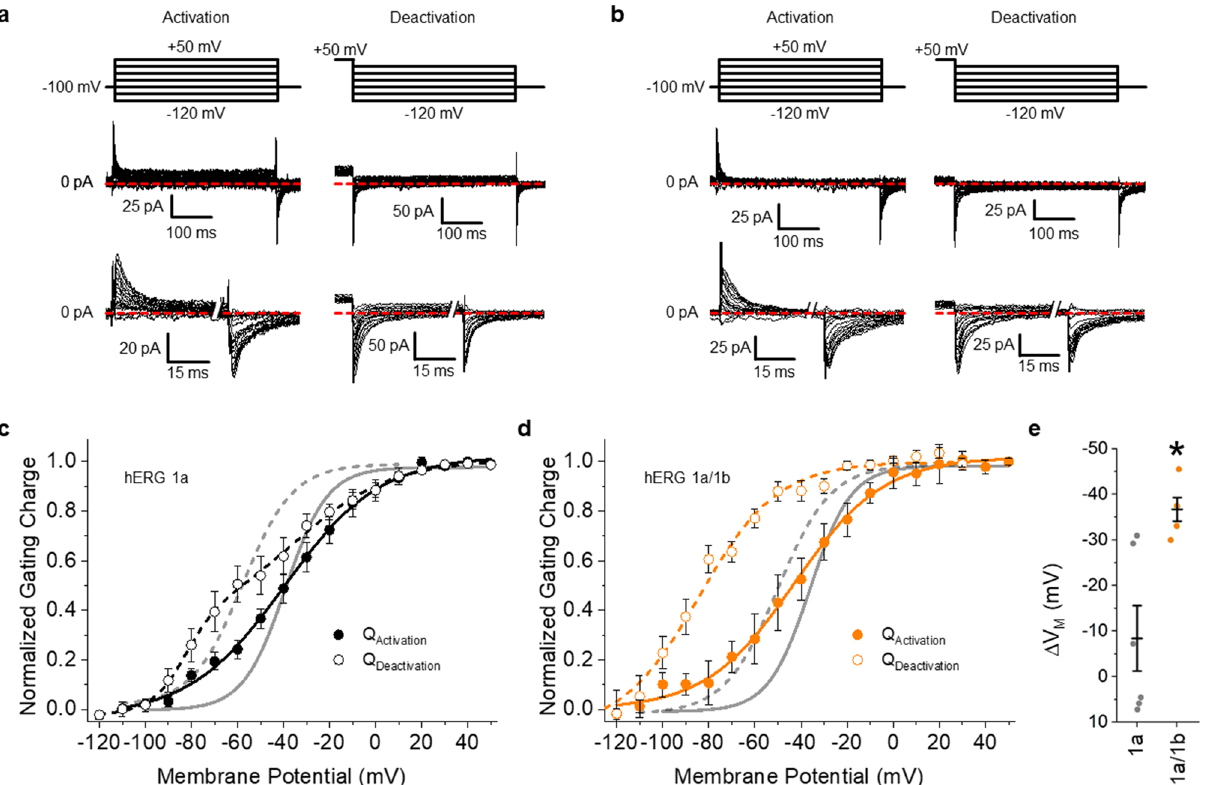
Figure 4. hERG 1b expression transforms hERG channel gating charge. ( a ) Activation and deactivation pulse protocols (top) and corresponding activation and deactivation gating current traces recorded at 36 ± 1 °C from HEK293 cells stably expressing hERG 1a. An expanded view of the gating current traces is show at bottom. ( b ) Activation and deactivation pulse protocols (top) and corresponding activation and deactivation gating current traces recorded at 36 ± 1 °C from HEK293 cells stably expressing hERG 1a and hERG 1b. An expanded view of the gating current traces is show at bottom. ( c ) Voltage dependence of hERG 1a gating charge activation (filled circles) and deactivation (open circles). Gating currents elicited during the test pulse were integrated, and the resultant gating charge was normalized, plotted as a function of test potential and fitted with a Boltzmann function. Voltage dependence of ionic current activation and deactivation are shown in gray. ( d ) Voltage dependence of hERG 1a/1b gating charge activation (filled circles) and deactivation (open circles). Voltage dependence of ionic current activation and deactivation are shown in gray. Expression of hERG 1b with hERG 1a triggered disparate shifts in the voltage dependence of VSD and ionic deactivation. ( e ) The magnitude of hysteresis was quantified by subtracting the V median of deactivation from the V median of activation. Hysteresis was significantly larger when hERG 1b was coexpressed with hERG 1a ( n = 10) compared with hERG 1a expressed alone ( n = 8). All data are reported as mean ± SEM. * indicates p <